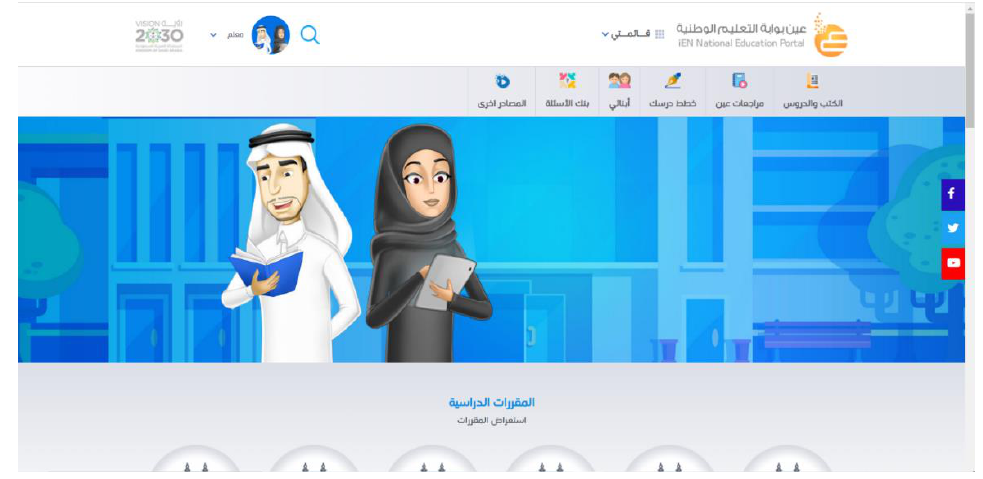
Figure 3. Faris homepage.